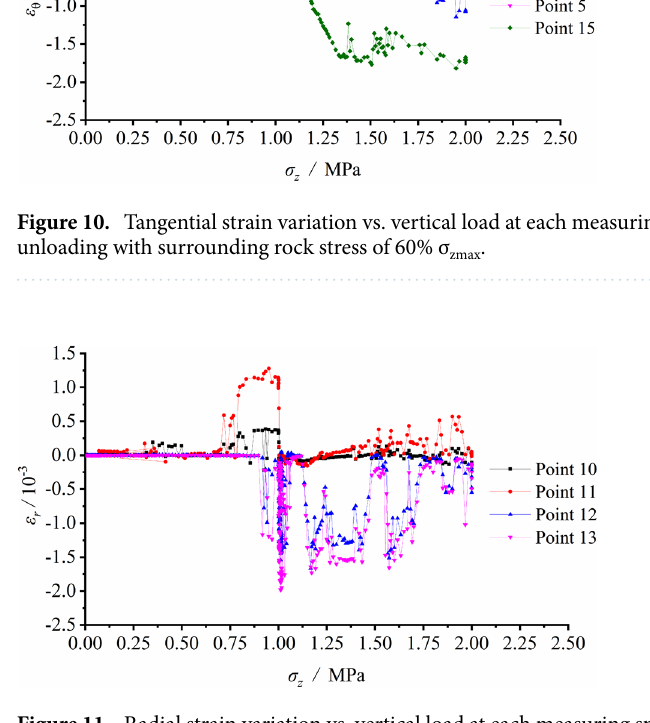
Figure 11. Radial strain variation vs. vertical load at each measuring spot around the tunnel during unloading with surrounding rock stress of 60% σ zmax